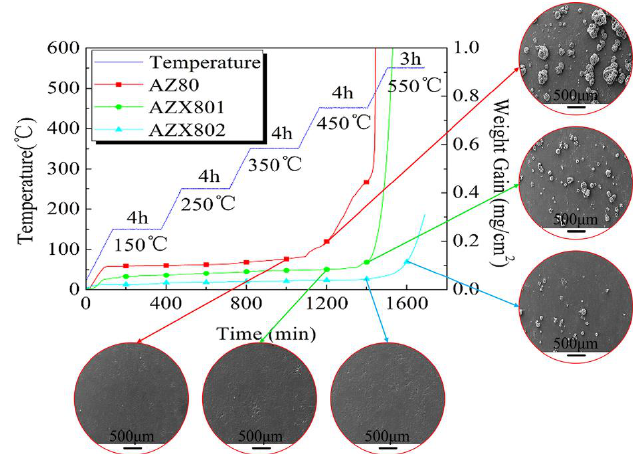
Figure 7. The weight gain curves and surface morphologies of AZ80, AZX801 and AZX802 alloys during multi-stage oxidation. The weight gain curves show all oxidation process with two oxidation stages: (i) the initial parabolic stage, and (ii) an accelerated oxidation stage. The first stage is considered to be an incubation